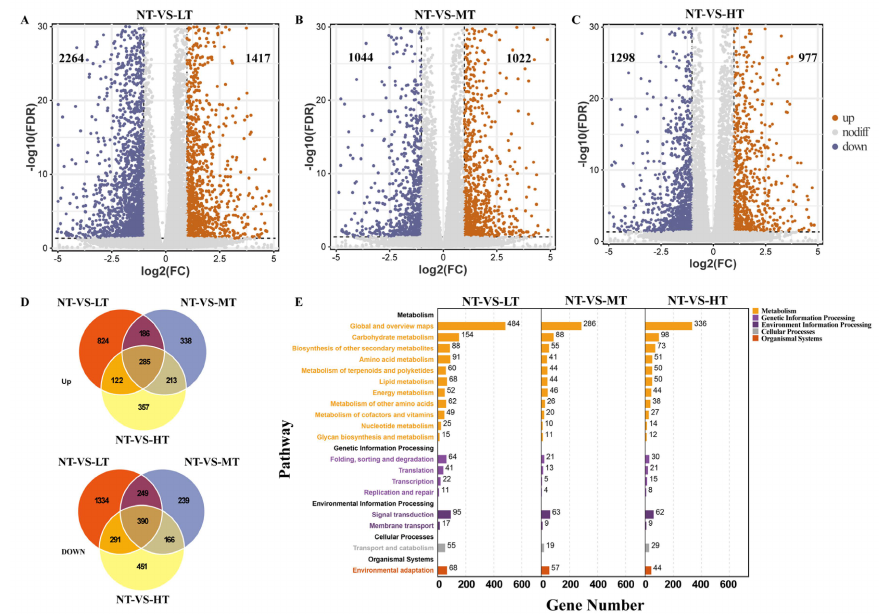
Figure 2. Transcriptomic responses in the roots of P. bournei with the different paclobutrazol treat- ments. ( A – C ) Summary of the numbers of up- and down-regulated differentially expressed genes (DEGs) in roots. ( D ) Venn diagrams showing the numbers of common and specific DEGs across four groups, including up-regulated DEGs and down-regulated DEGs in roots of P. bournei . ( E ) DEGs are significantly enriched in KEGG pathways of five biological functional processes. Signal transduction enriched the most DEGs in the environment information